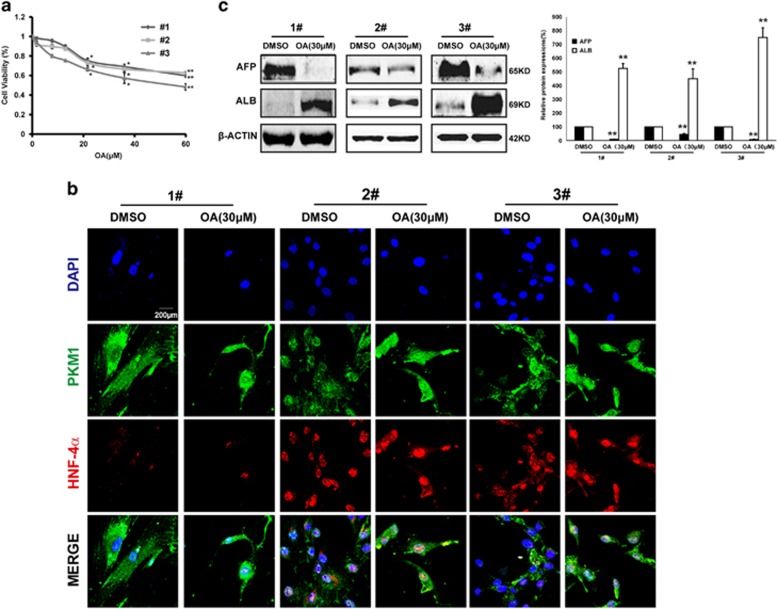
OA-induced differentiation of primary HCC. (a) Cell viability of 1, 2 and 3 primary HCC cells treated with various concentrations of OA were measured by MTT assay after 72 h treatment. (b) Immunofluorescent staining of 1, 2 and 3 primary HCC cells treated with DMSO or OA. HNF-4α was stained with red and PKM1 green. Nuclei are stained with DAPI (blue). (c) WB of AFP and ALB in the whole-cell lysates. Bars, SD. *P<0.05 or **P<0.01 versus DMSO-treated cells